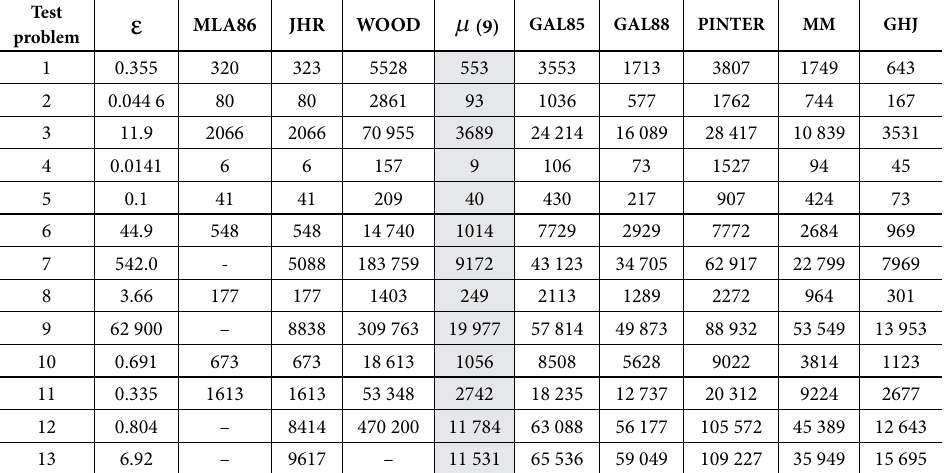
Table 2. The numbers of function evaluations for n = 2 Test problem